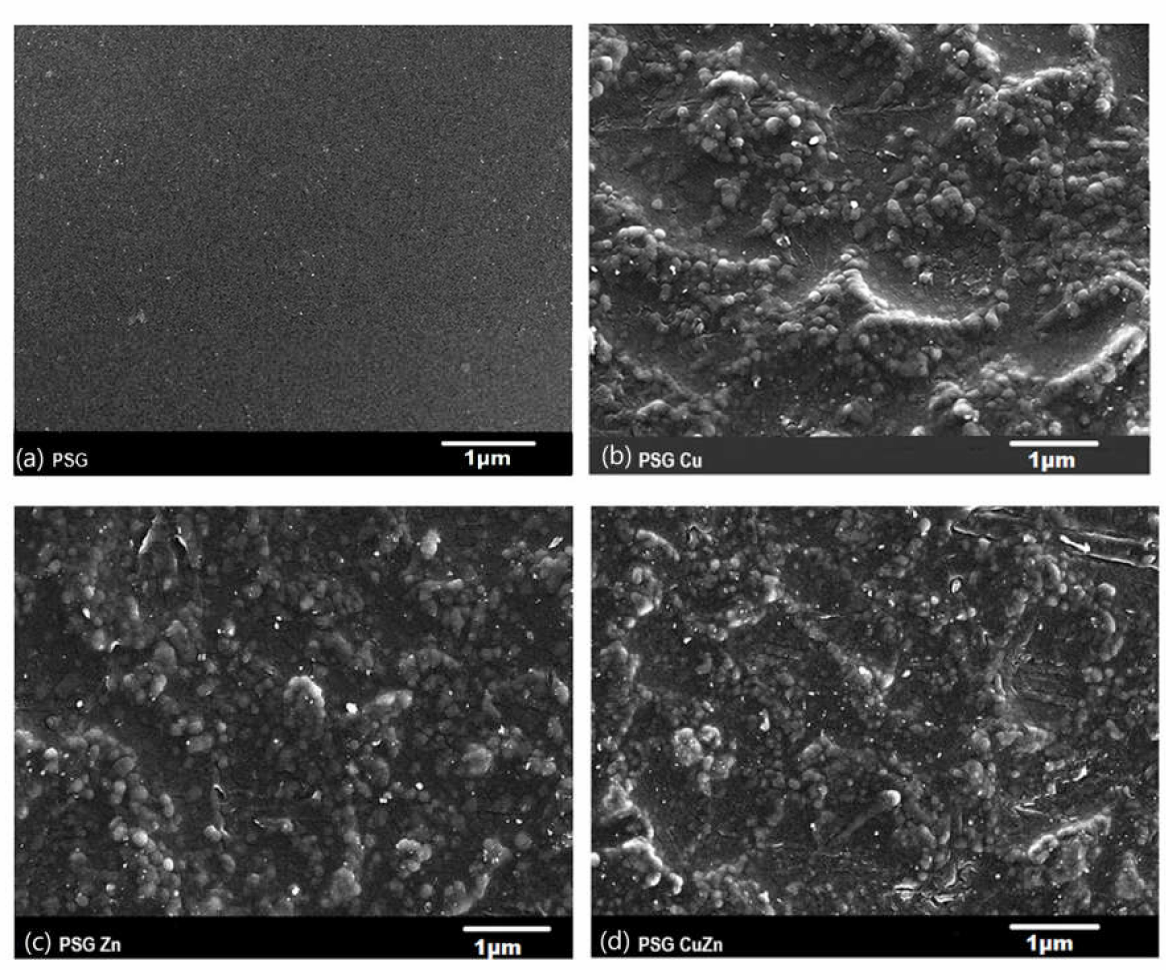
Figure 1. Scanning electron microscopy image of ( a ) PSG, ( b ) PSG-Cu, ( c ) PSG-Zn, and ( d ) PSG-CuZn